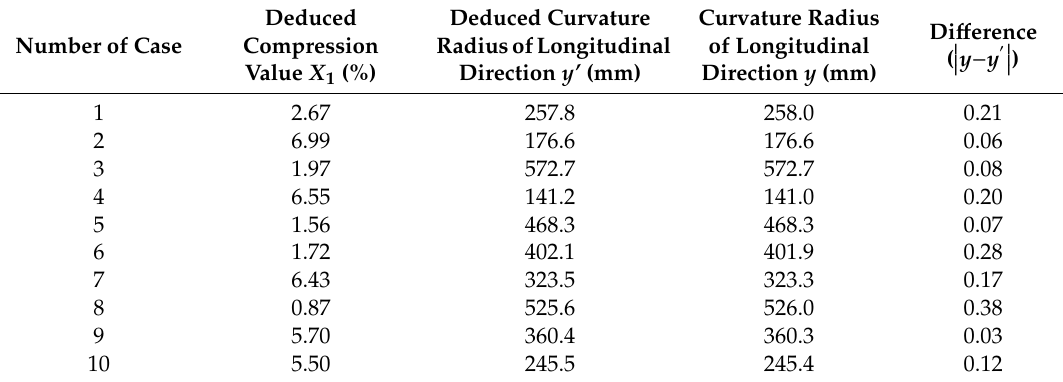
Table 10. Deduced results of the compression condition for the convex type.